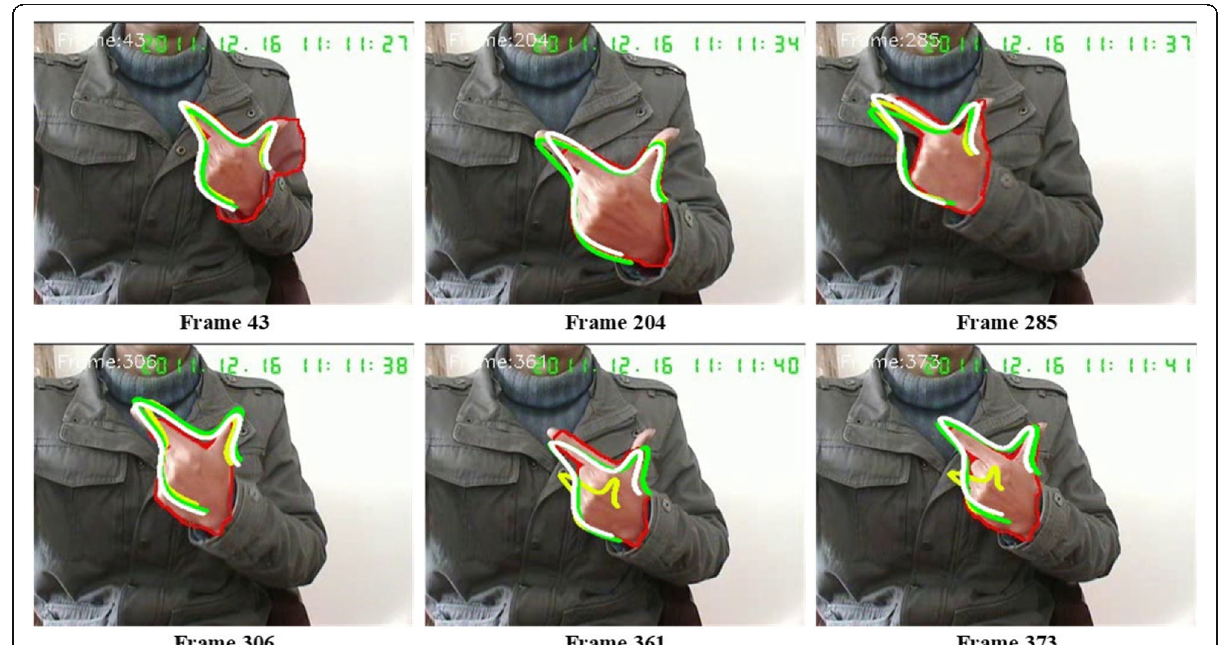
Fig. 4 Tracking result of Hand1. Yellow — UKPF, white — MHMM-UPF, red — Hough Tracker, green — proposed